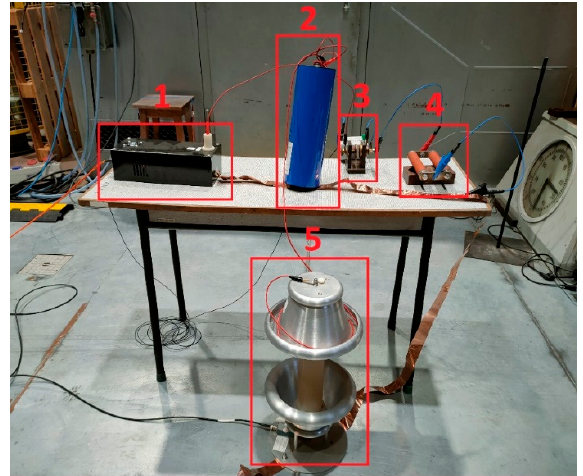
Figure 13. Block scheme of the measurement setup.